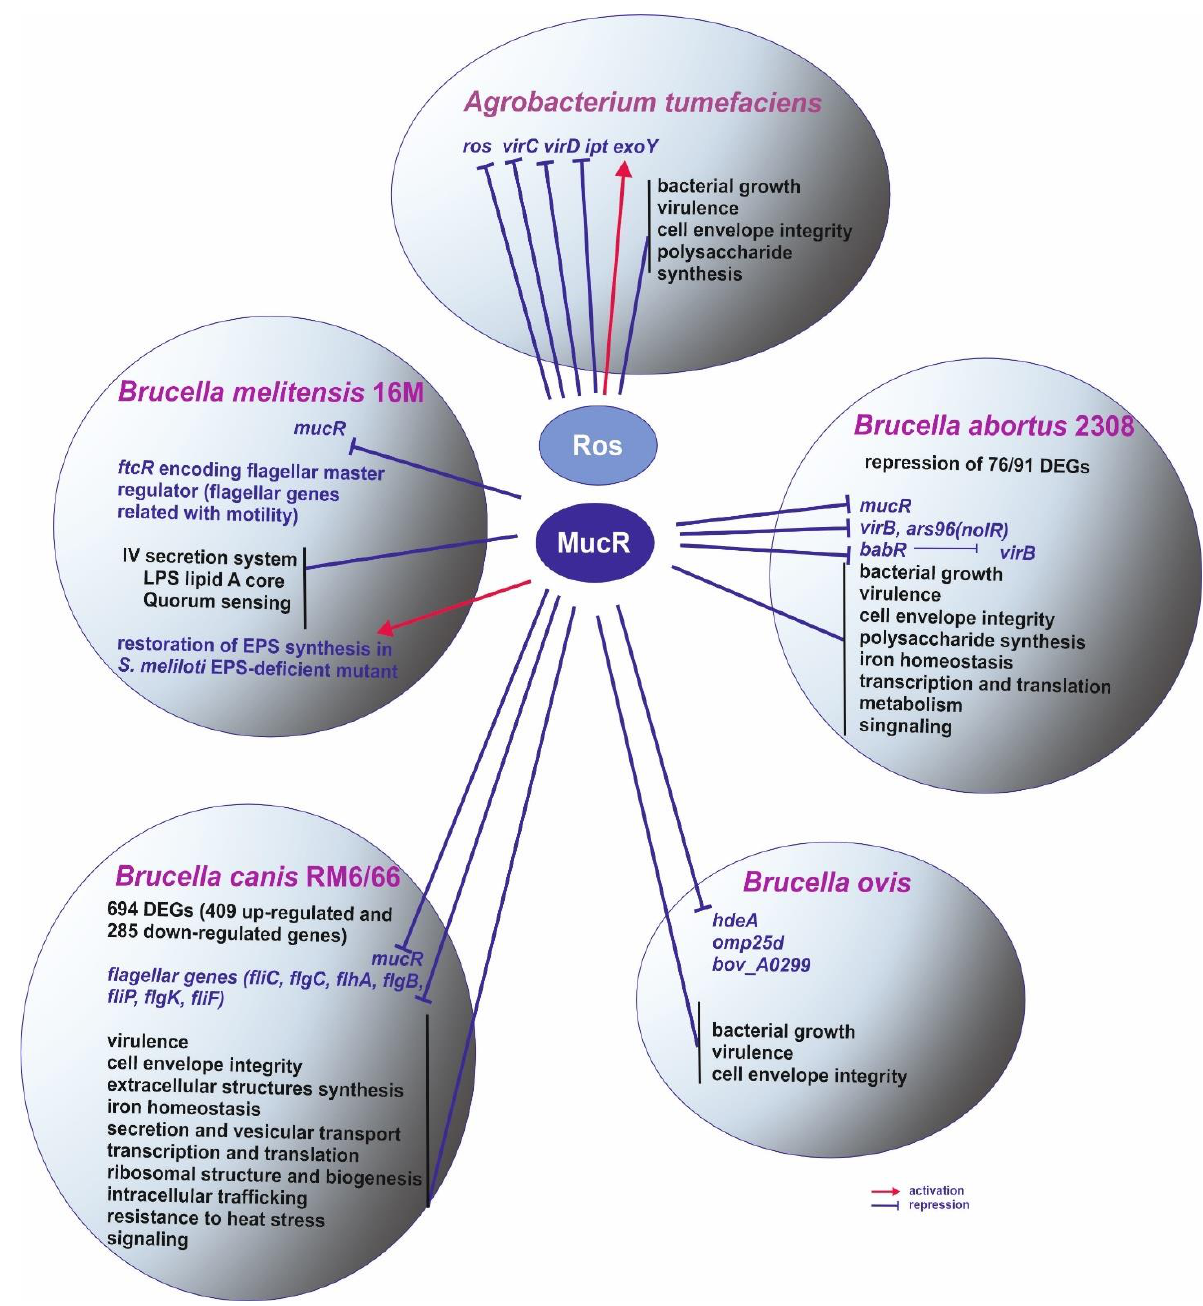
Figure 2. MucR/Ros proteins from different pathogenic bacteria: Brucella and Agrobacterium tumefaciens and their roles in regulation of expression of various genes involved in several cellular processes and adaptation to environmental stresses.